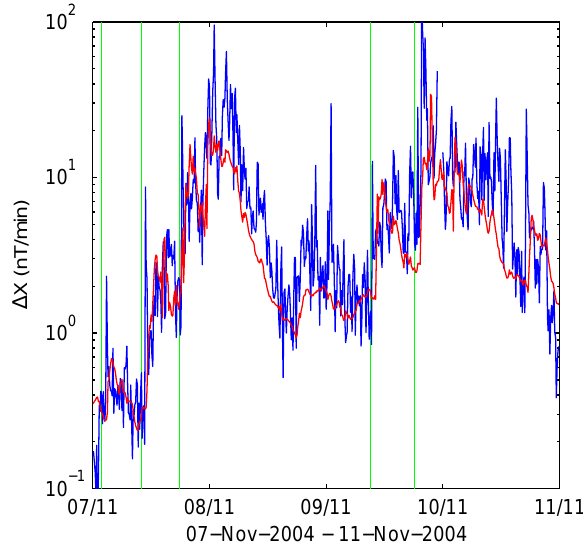
Fig. 3. The figure shows the observed (blue) and predicted (red) 10-min RMS 1Y